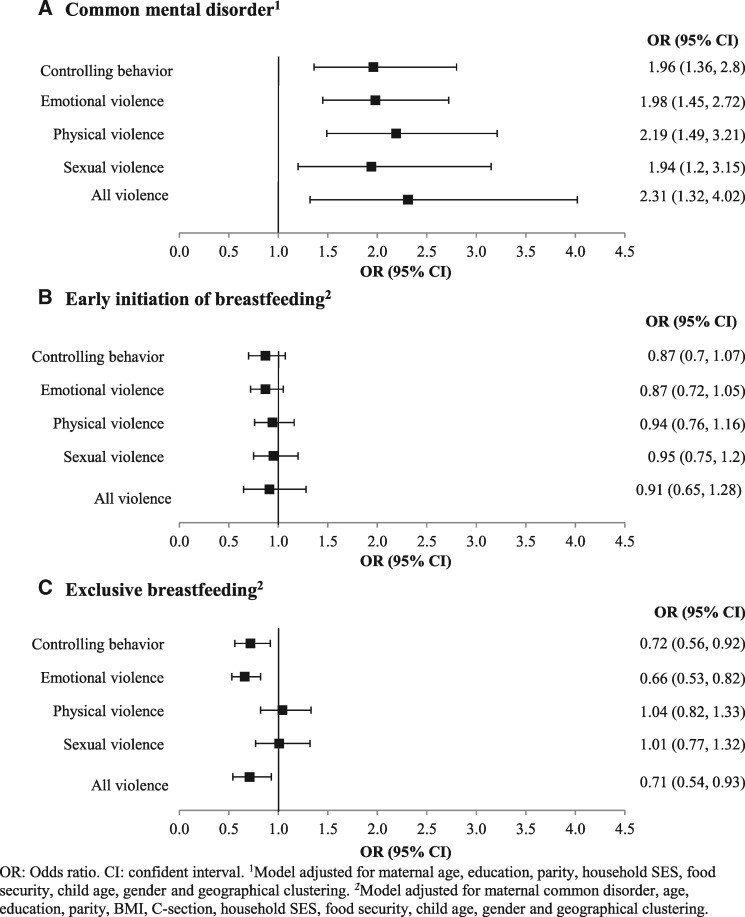
Association between IPV and CMD and breastfeeding practices. (A) CMD1. (B) EIBF2. (C) EBF2. 1Model adjusted for maternal age, education, parity, household SES, food security, child age, gender and geographical clustering. 2Model adjusted for maternal common disorder, age, education, parity, BMI, C-section, household SES, food security, child age, gender and geographical clustering